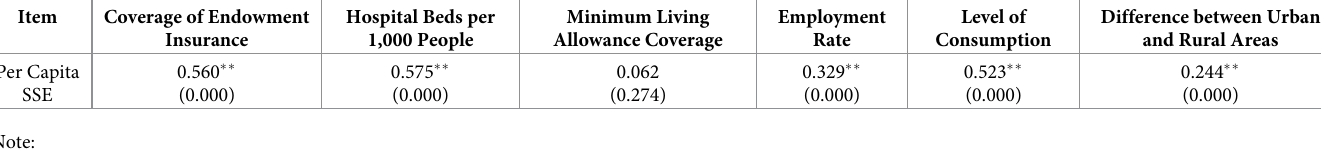
Table 2. Pearson correlation test of the input and output